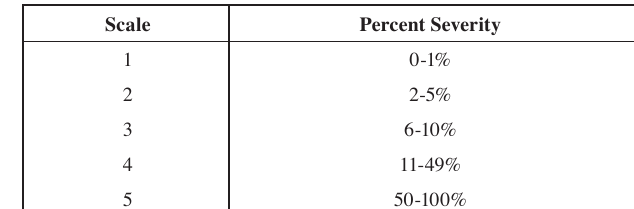
Tab. 1: Disease severity scale for postharvest